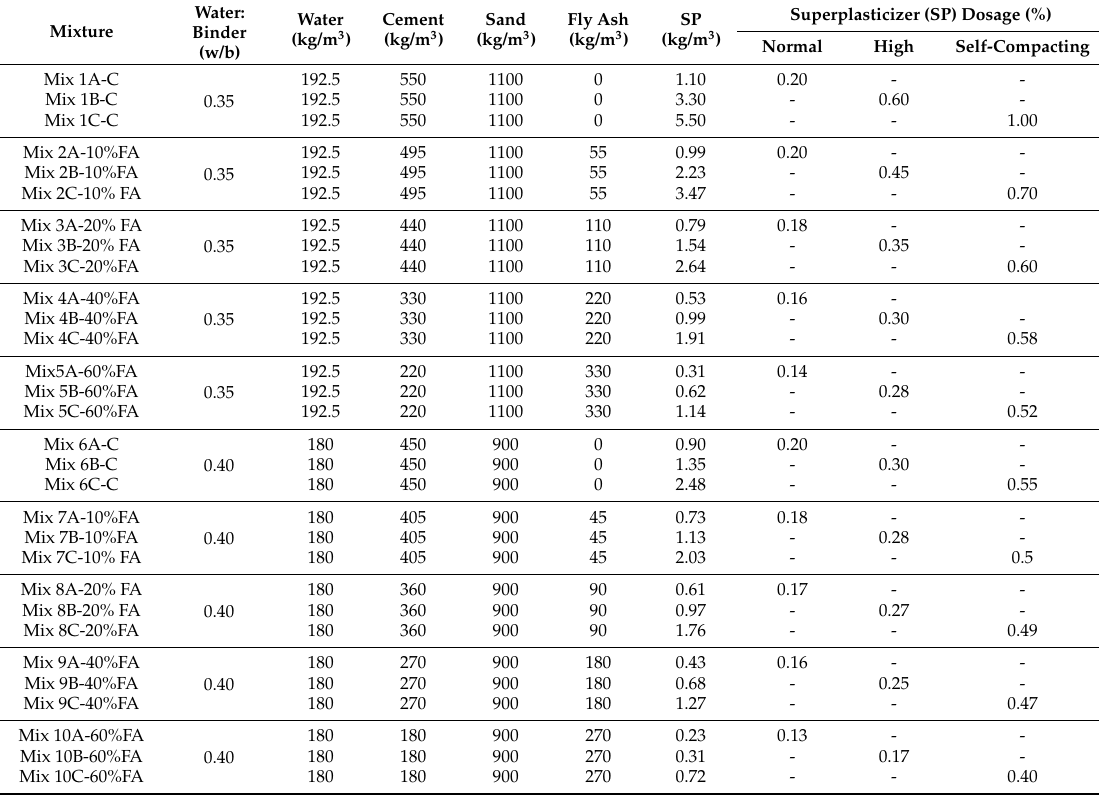
Table 1. Mix proportion w/b 0.35 and 0.40.